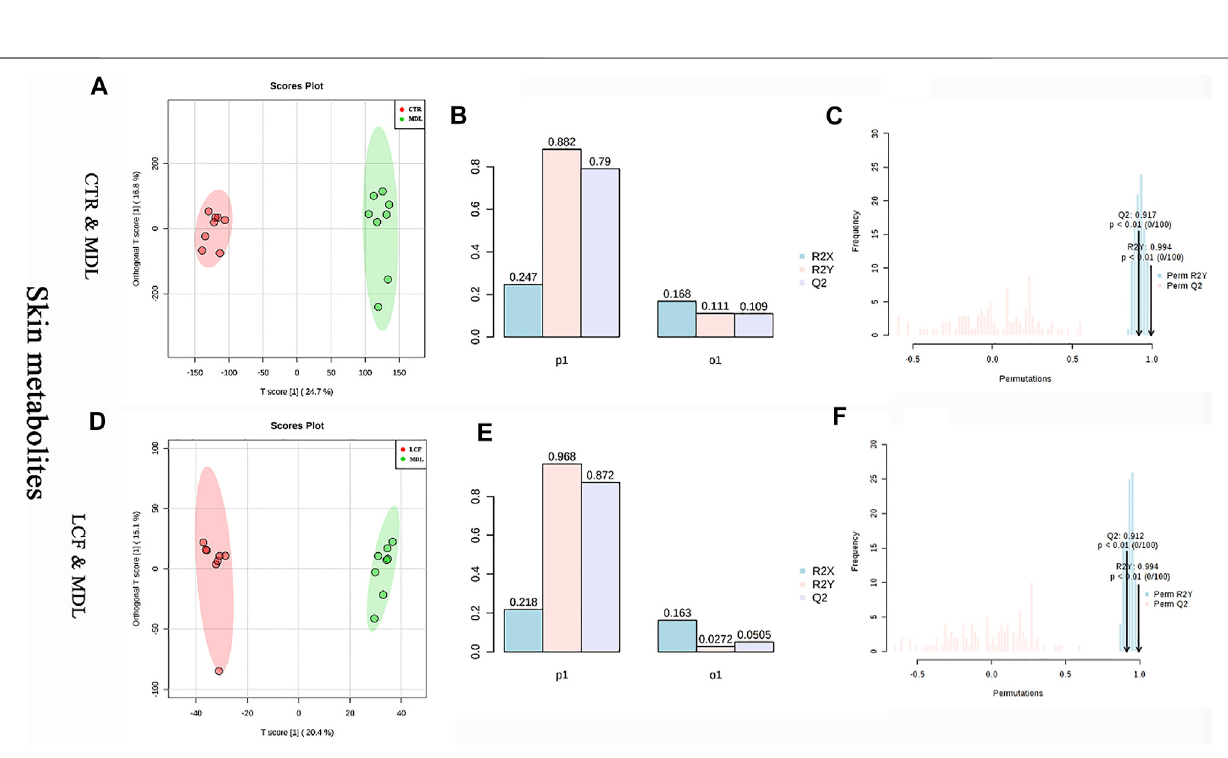
Frontiers in Pharmacology | www.frontiersin.org February 2022 | Volume 13 | Article 832088